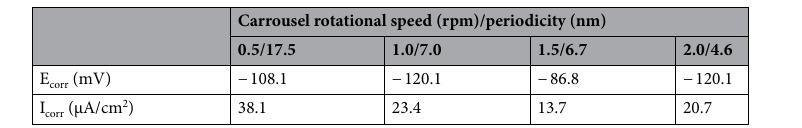
Table 3. Values of E corr and I corr obtained in the potentiodynamic polarization tests for the multilayers produced with different